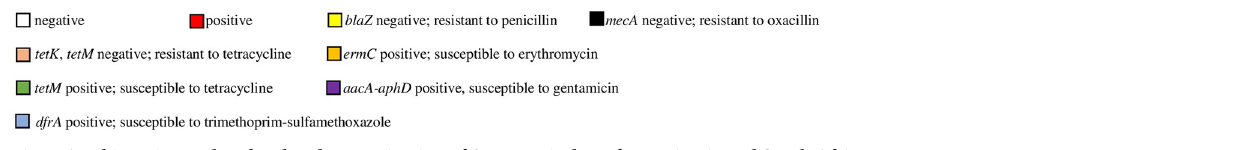
Fig 1. Antibiotyping and molecular characterization of S . aureus isolates from Nigeria and South Africa.